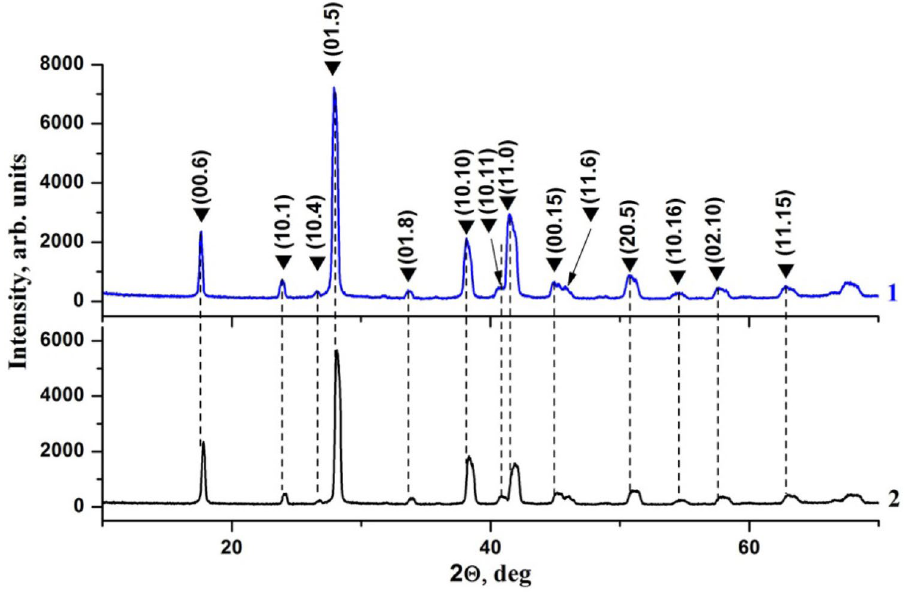
Fig. 3 XRD patterns of the studied samples before (1) and after the first PT